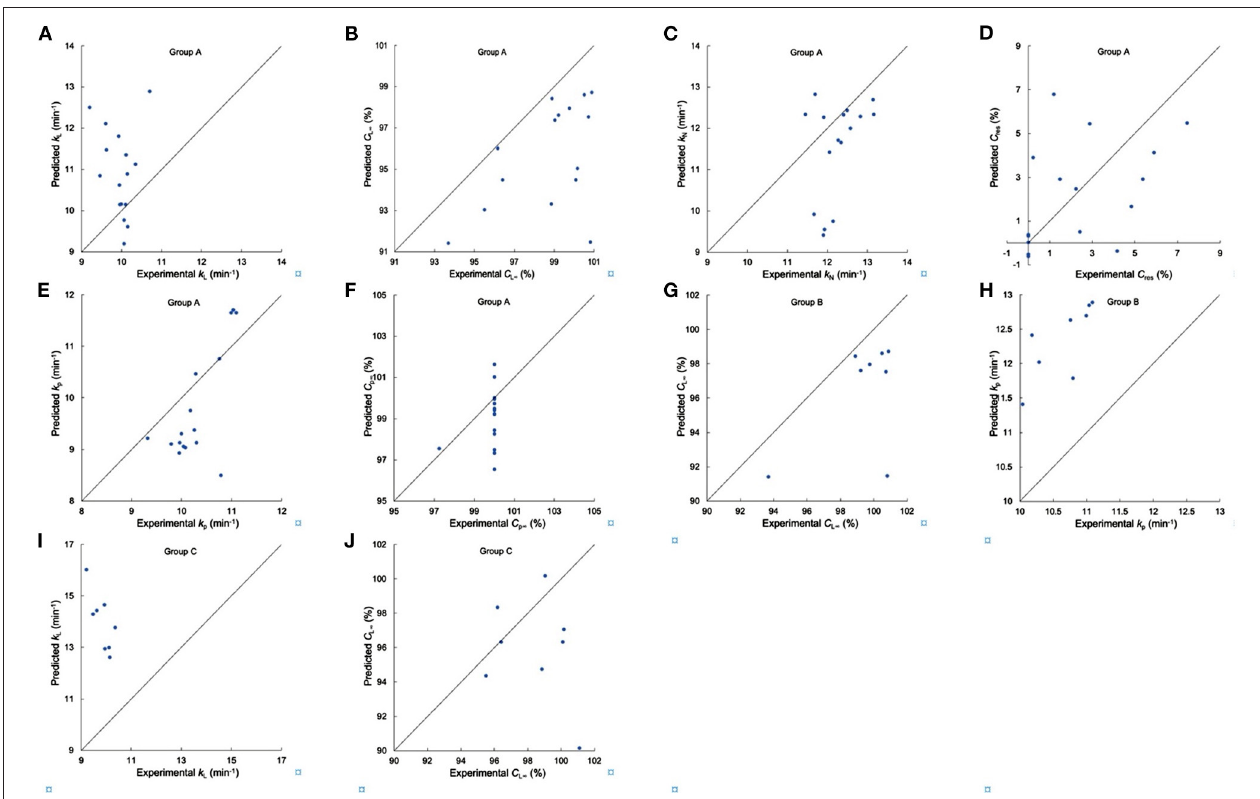
FIGURE 6 | Testing the suitability of linear regression models for in vitro digestion properties. (A–F) Comparison of experimental and predicted k L , C L ∞ , k N , C res , k p and C p ∞ from Group A, respectively, (G,H) comparison of experimental and predicted C L ∞ , and k p from Group B, respectively, (I,J) comparison of experimental and predicted k